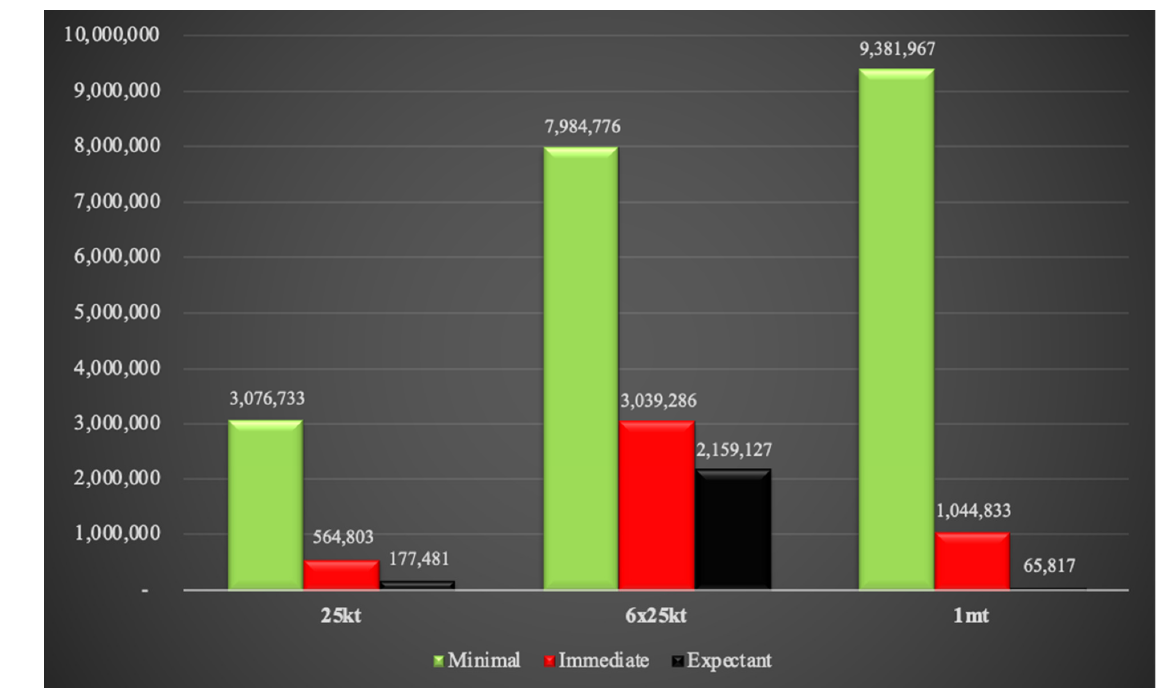
Figure 13. Fallout radiation exposure at 24 h.